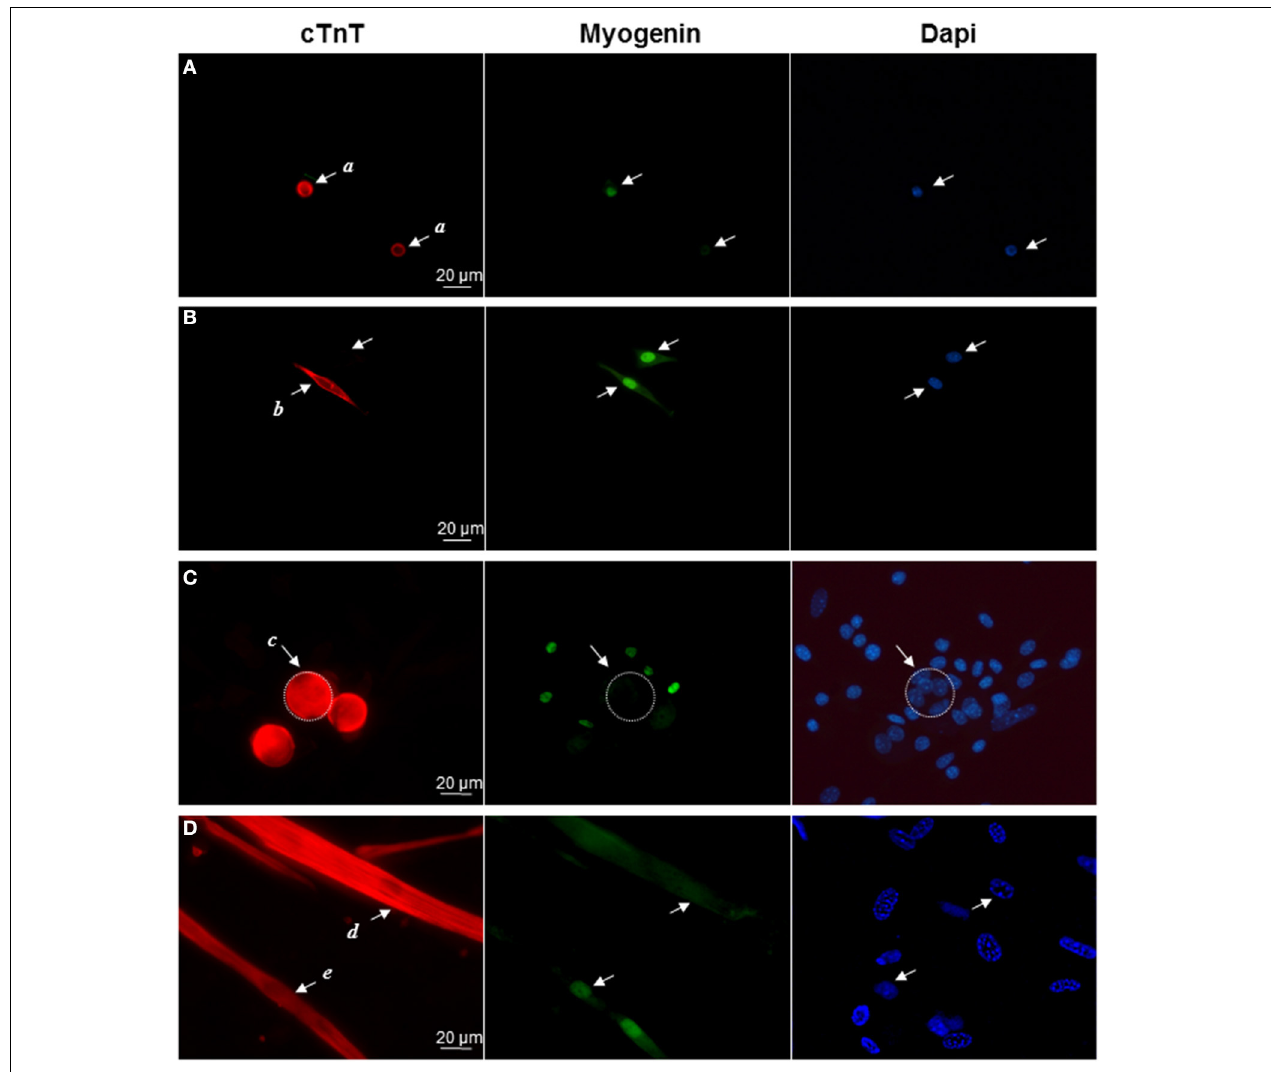
FIGURE 2 | Differential expression of cardiac and skeletal markers reflect cell heterogeneity in myogenic clusters. Immunolabeling of cardiac TnC (red) and myogenin (green) in (A) small round cells ( a cells),